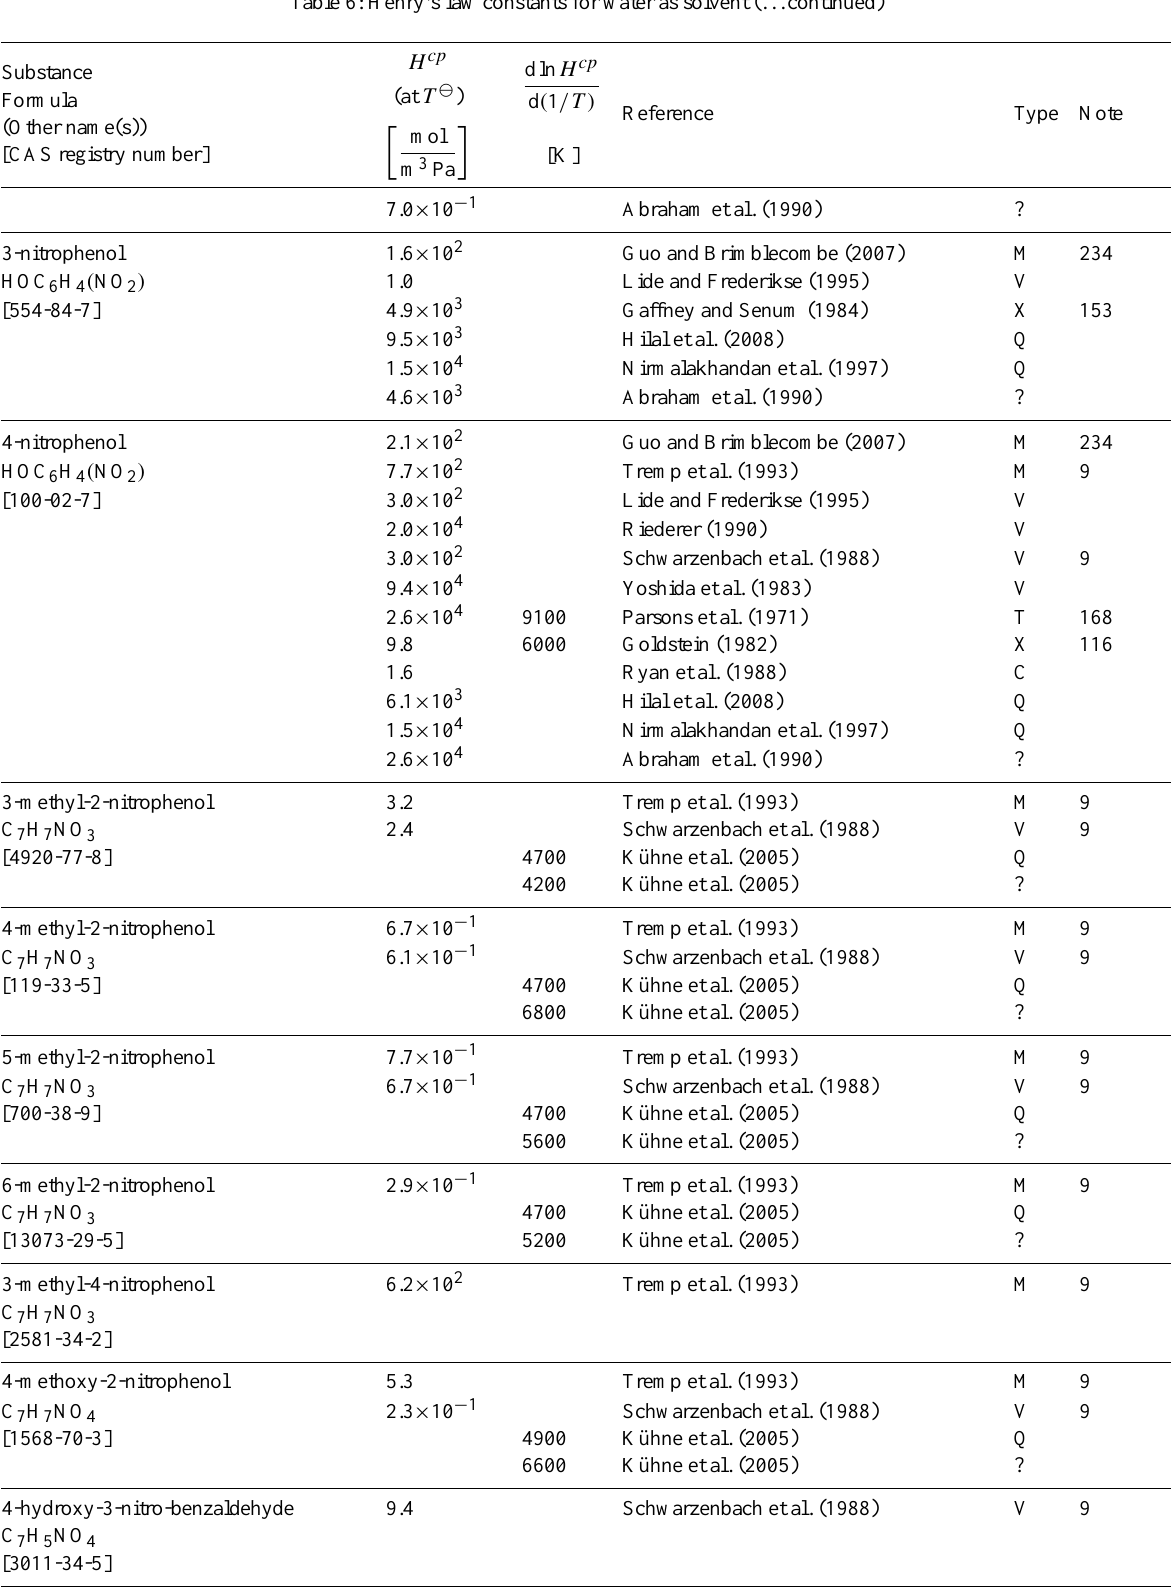
Table 6: Henry’s law constants for water as solvent